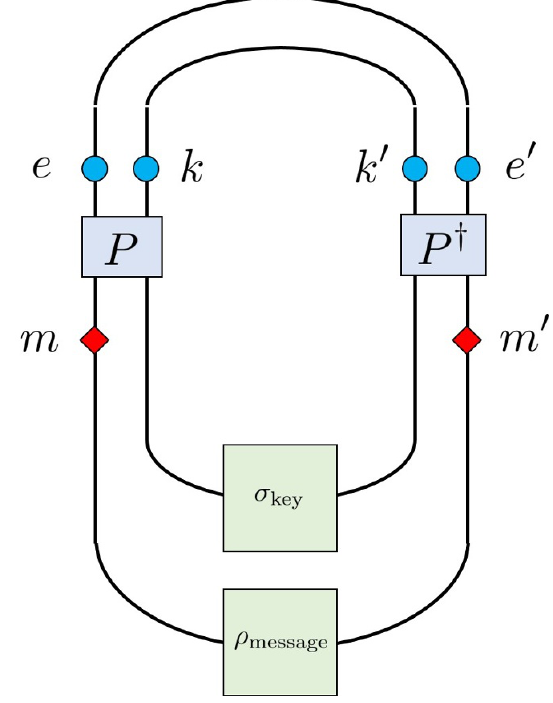
Figure 26 . A diagram for the one-time pad. Here, (cid:26) message is the state of the message, (cid:27) key is the state of the secret key, and P is encrypts the message using the secret key, as described in eq. (C.9) and the surrounding